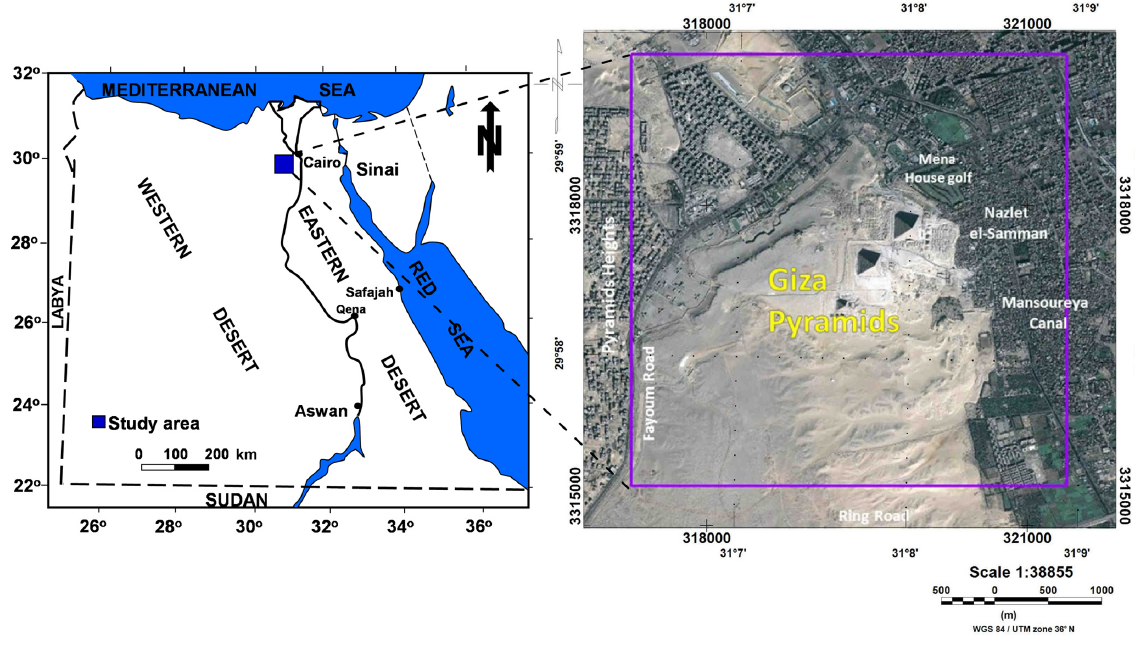
Figure 1. Location map of the study area at the pyramid plateau.